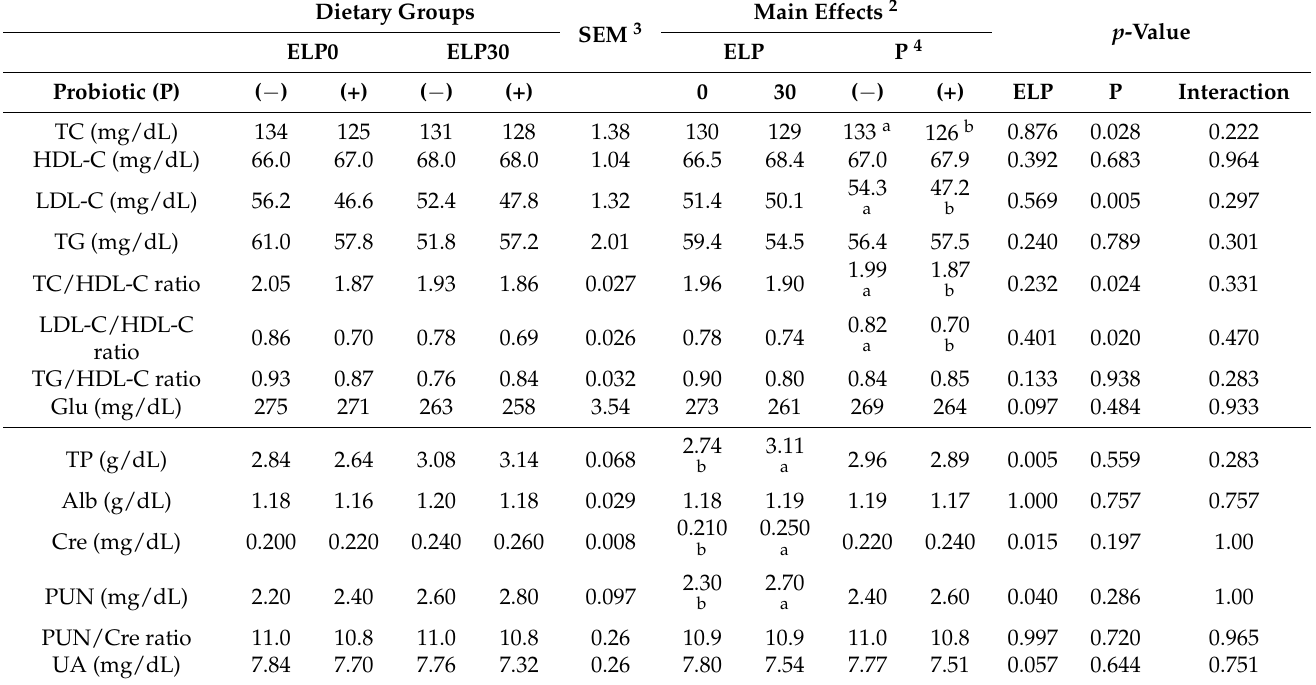
Table 4. Plasma biochemical profile 1 of